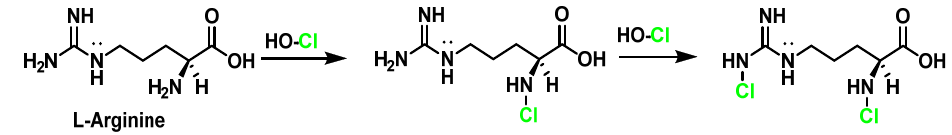
Figure 28. Proposed structures of chlorinate L-arginine products.